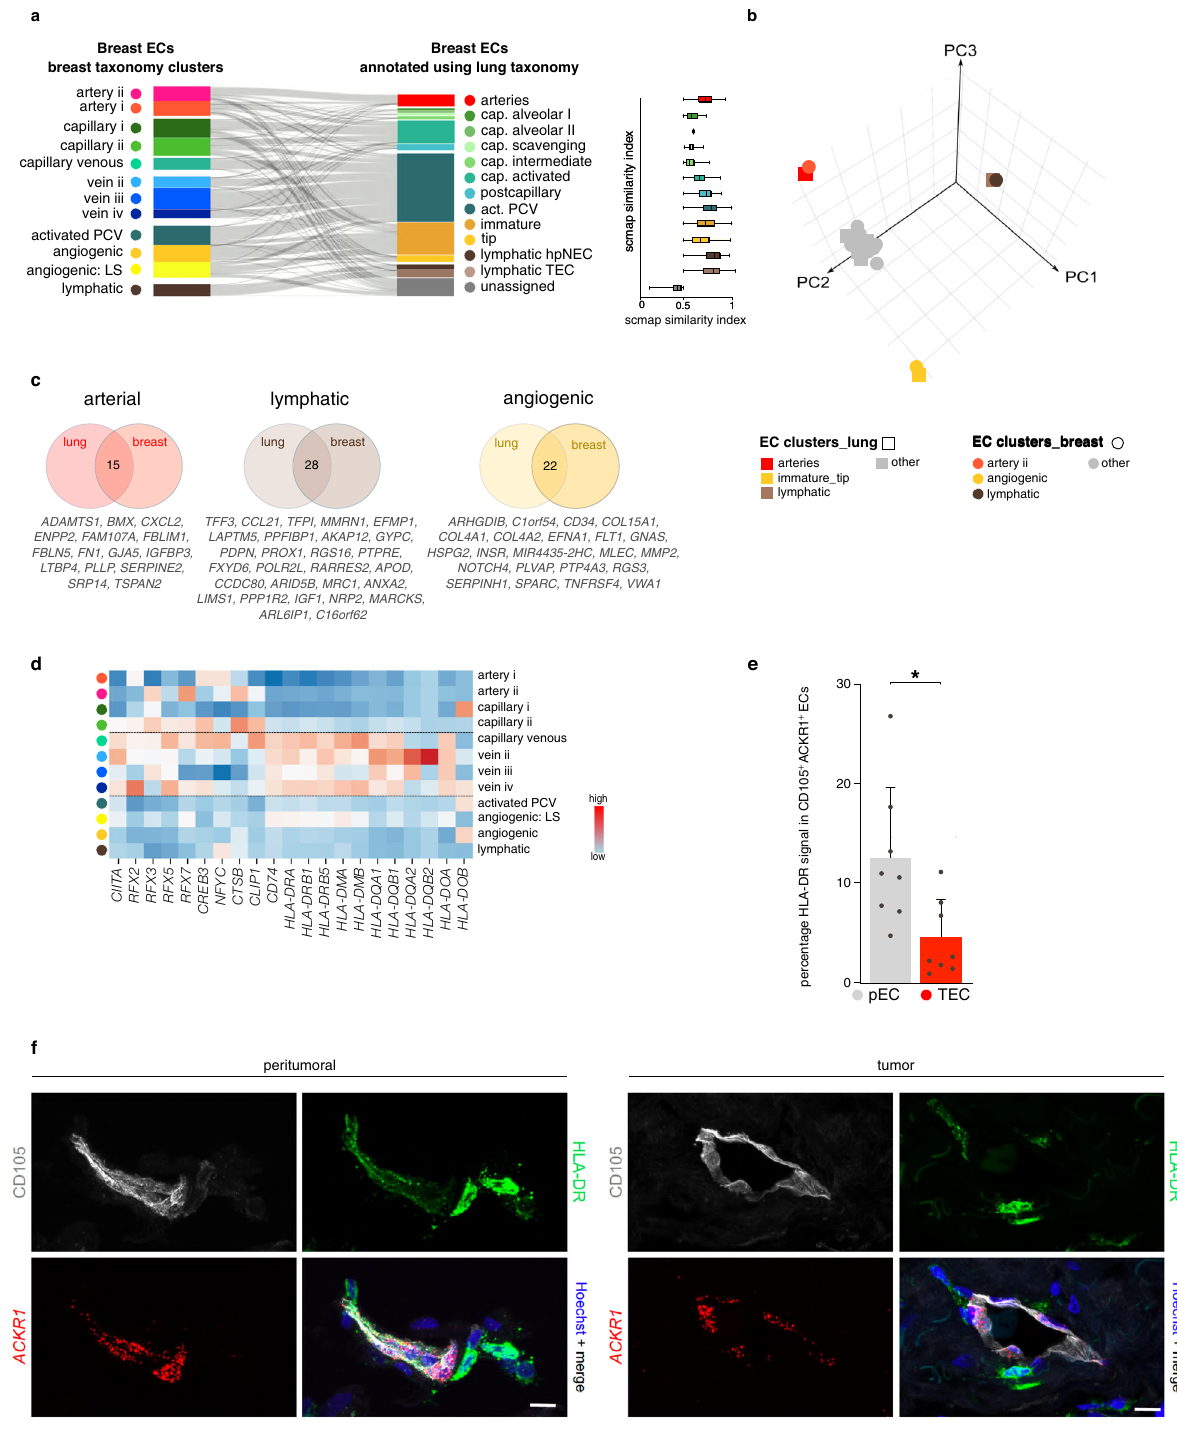
Fig. 2 | Transcriptomic congruency ofECs in breast and lung. a Sankey diagram (left panel), showing the scmap cluster projection of annotated (peri-) tumoral breast-derived ECs (left part; n = 8433 endothelial cells) to subclusters of the EC taxonomy in non-small cell lung carcinoma (right part) and box plots (right panel) depicting the scmap similarity index. PCV post-capillary venules, EC endothelial cell,LSlowersequencingdepth.Boxesextend fromthe25 th to75 th percentiles,line inthemiddleoftheboxisplottedatthemedian.Whiskers=minandmax. b Three- dimensional principal component (PC) analysis on the pairwise Jaccard similarity coef fi cientsofmarkergenesbetweenECsubtypesinlungandbreast.Colorcoding according to EC subtypes (lung – squares; breast – circles). c Venn-diagramsof the top-50markergenesintheindicated EC subtypesinlung and breastECs.Numbers